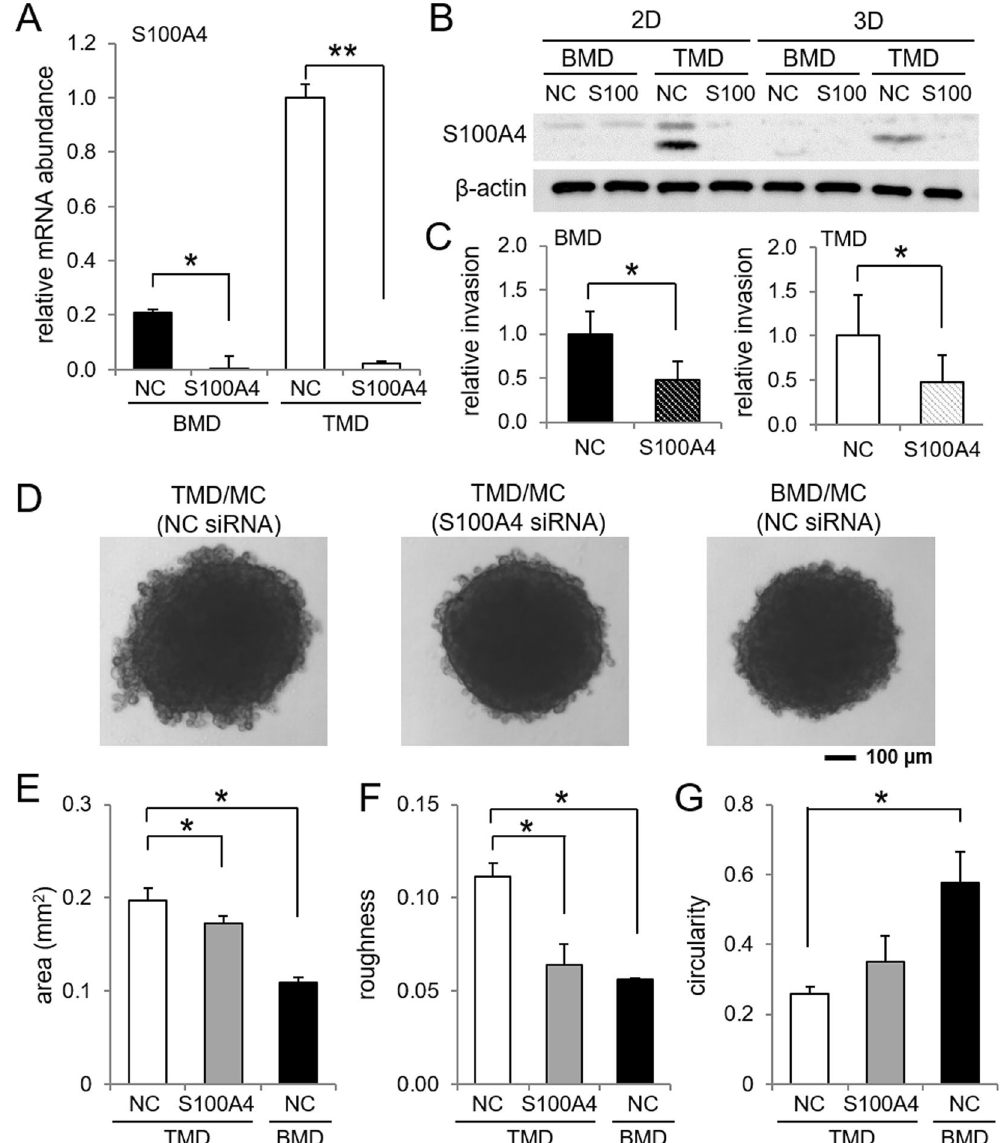
Figure 3. Effects of S100A4 siRNA in invasion capability and spheroid formation in TMD cells. Of note, NC = non-specific control siRNA, 2D = 2-dimensional culture, and 3D = 3-dimensional spheroid culture. The single and double asterisks indicate p < 0.05 and p < 0.01, respectively. ( A , B ) Reduction of S100A4 mRNA and protein levels by S100A4 siRNA, respectively. Full length blots are presented in Supplementary Figure 2. ( C ) Reduction in invasion capability by S100A4 siRNA in TMD cells and BMD cells. ( D ) Representative images of spheroids by TMD cells, S100A4 siRNA treated TMD cells, and BMD cells in the presence of MC3T3 osteoblast-like cells. ( E – G ) BMD-like transformation of three spheroid parameters (area, roughness, and circularity, respectively) by S100A4